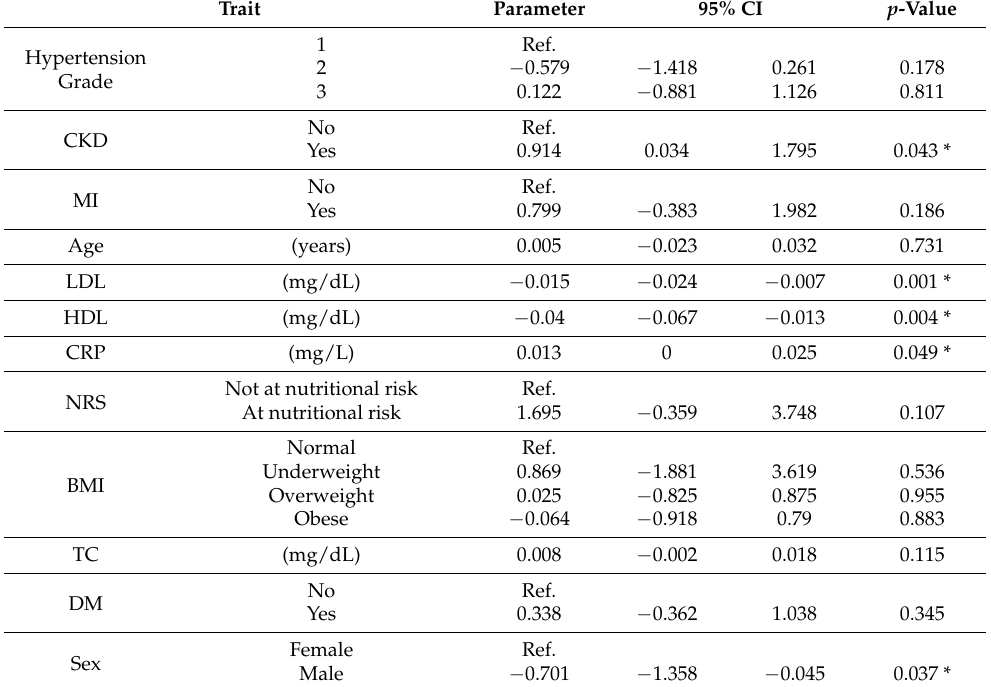
Table 7. Multivariate linear regression